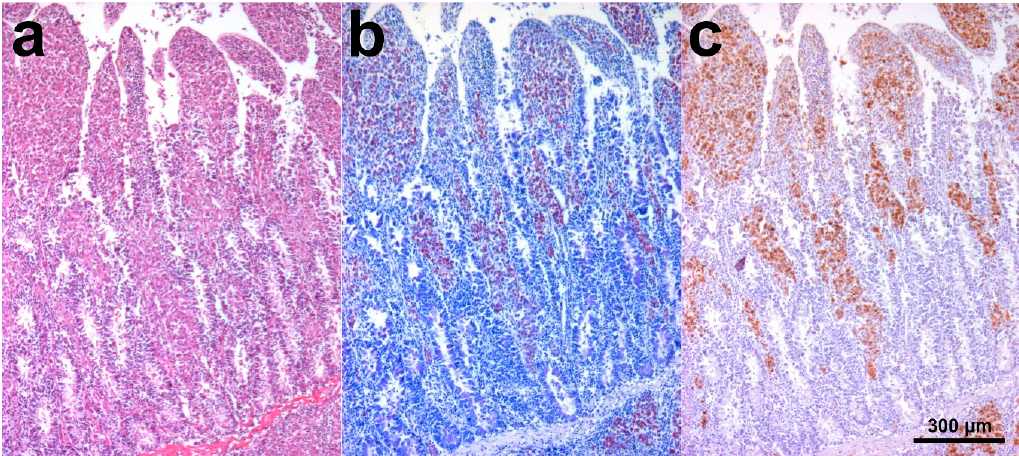
Figure 1. Scimitar ‐ horned oryx (SHO) 4, ileum. ( a ) Numerous epithelioid macrophages were visible in the lamina propria. At the bottom right of the image, a macrophage aggregate is visible in the submucosa. Hematoxylin and eosin (H&E) stain; ( b ) Myriad acid ‐ fast (AF) bacilli were highlighted within intestinal macrophages. Ziehl–Neelsen (ZN) stain; ( c ) Mycobacterium avium subsp. paratuberculosis (MAP) antigens were abundantly highlighted within intestinal macrophages.